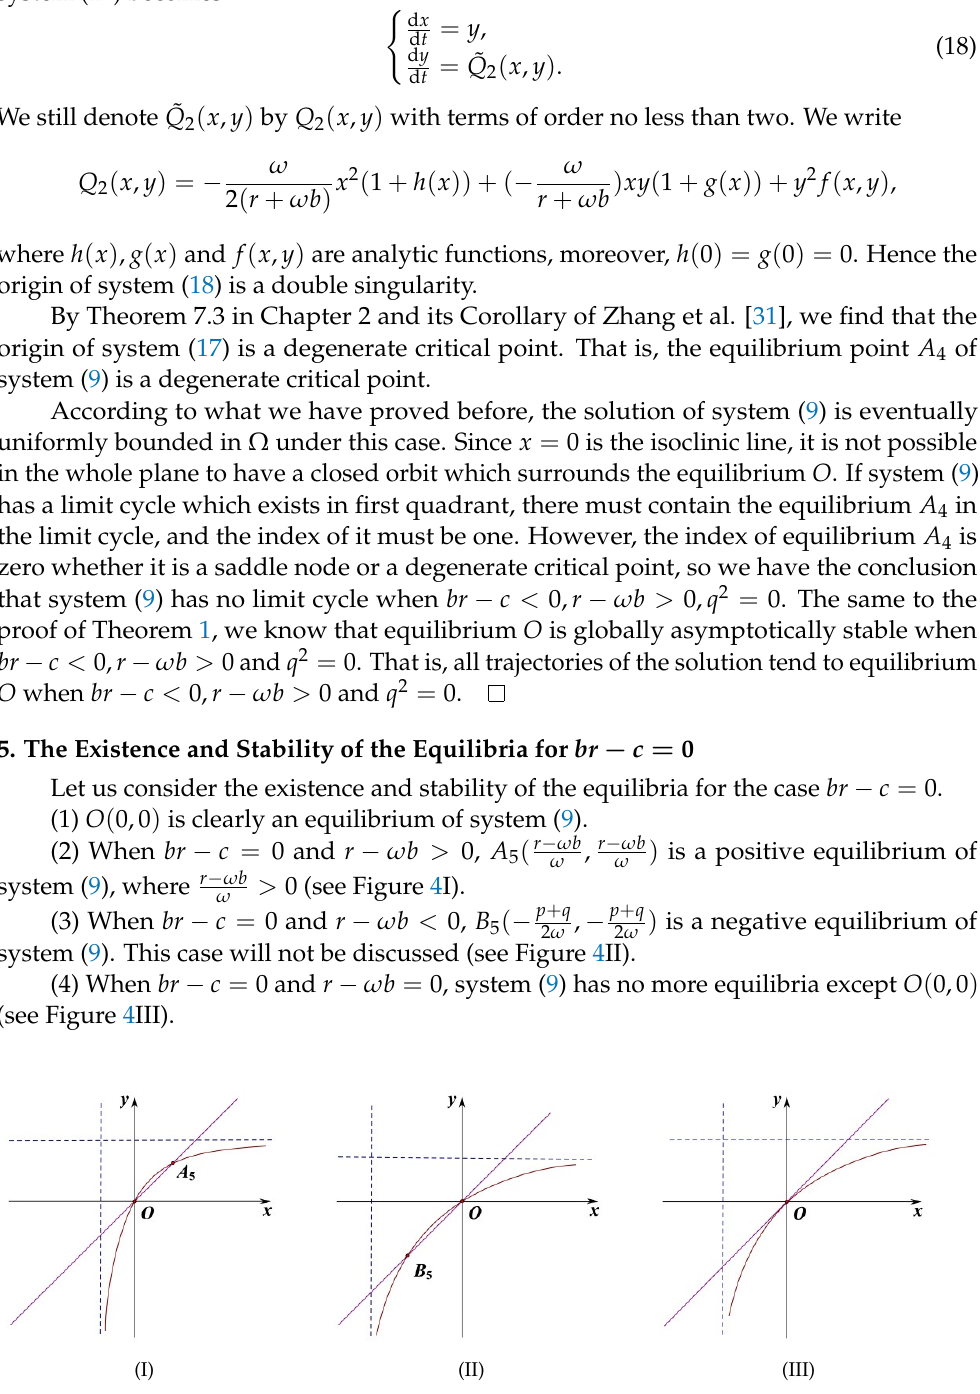
Figure 4. Figure ( I – III ) show the locations of the equilibria under the case br − c = 0, respectively. x denotes the density of the population. y indicates the impact of distributed time delay. Figure ( I ) corresponds to the case br − c = 0 and r − ω b > 0; Fiure ( II ) shows the case br − c = 0 and r − ω b < 0 and Figure ( III ) corresponds to the case br − c = 0 and r − ω b =